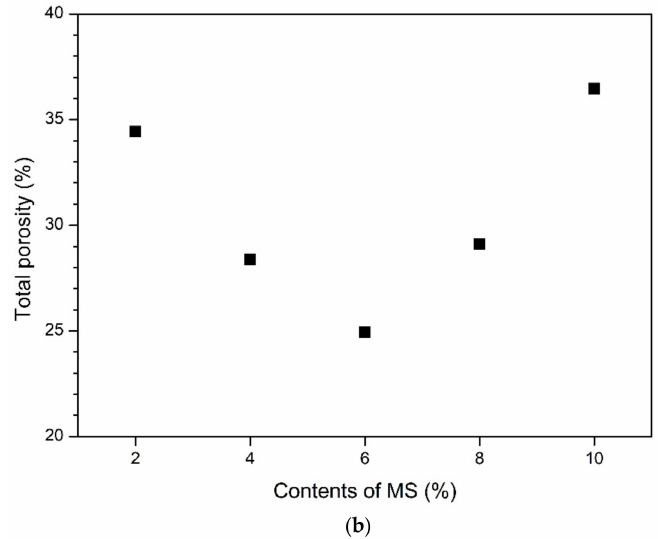
Figure 3. Pore structures at 28 days samples: ( a ) pore size distribution, ( b ) total